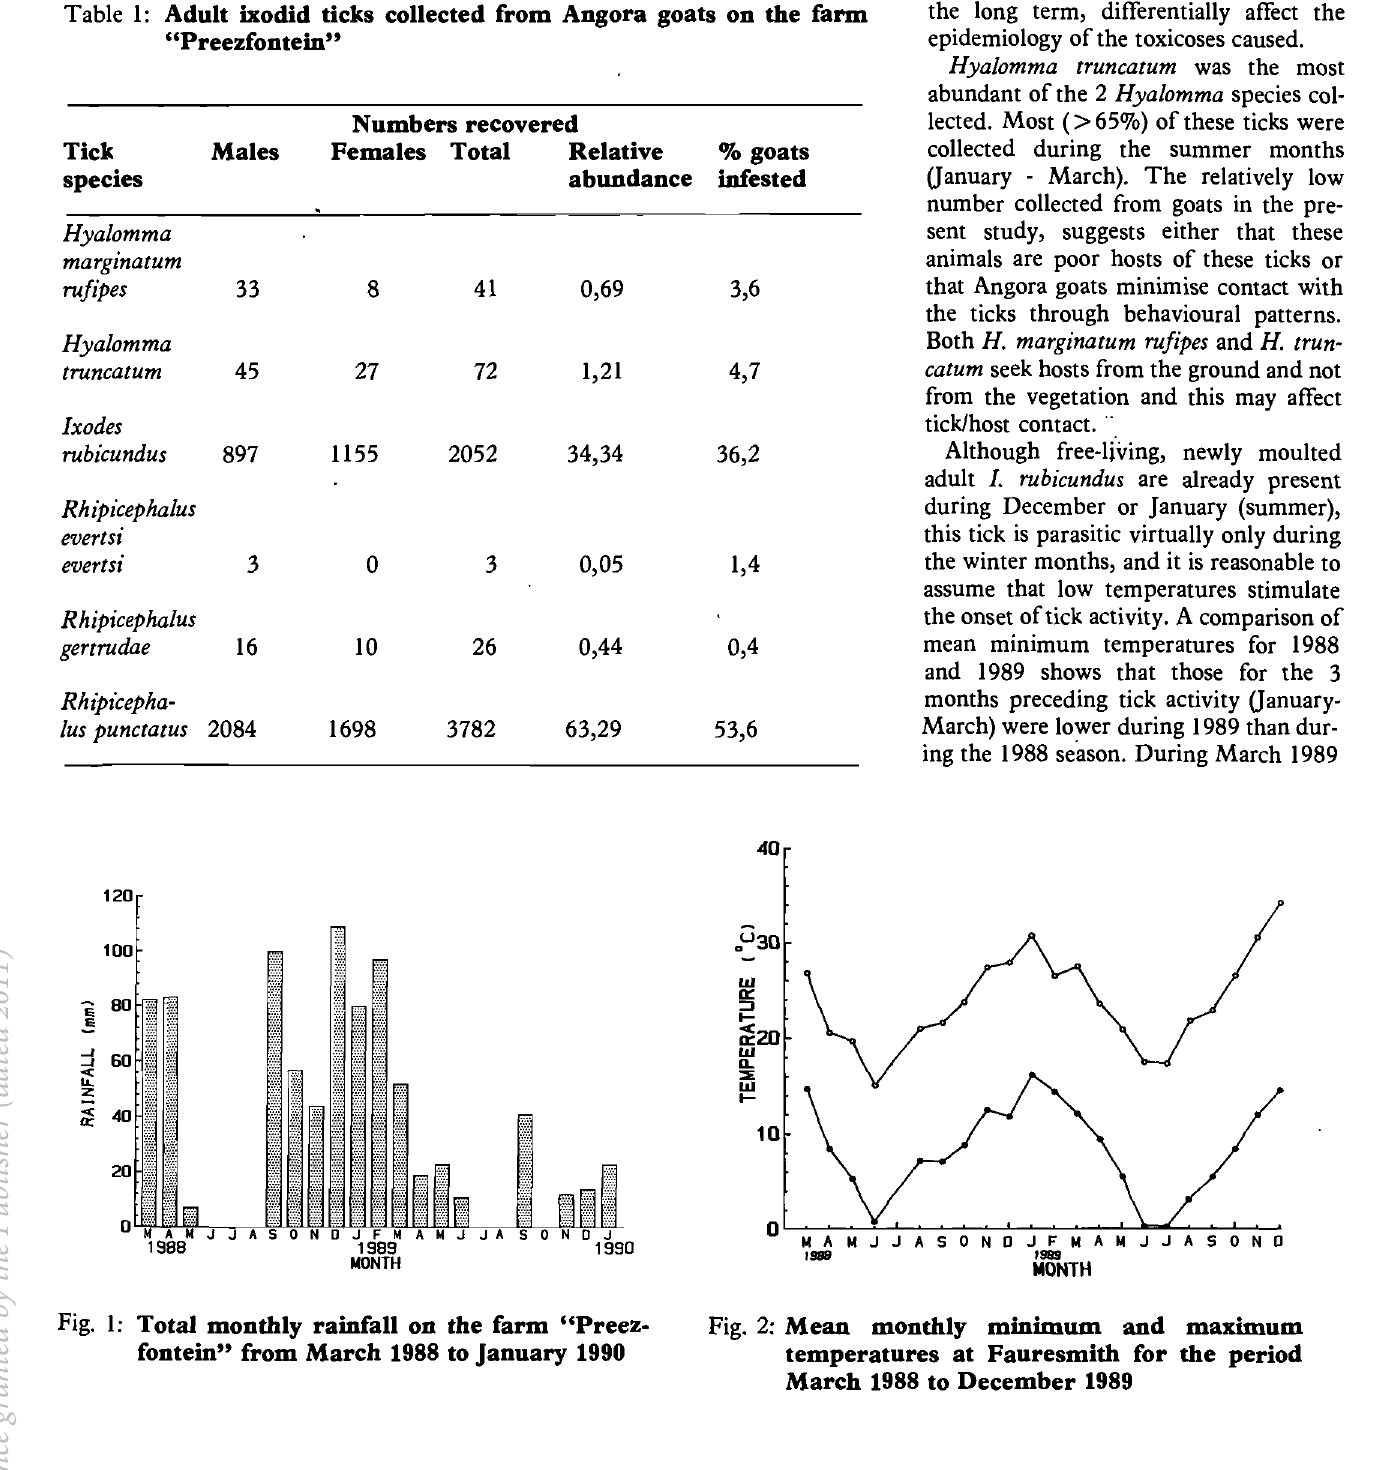
Fig. 1: Total monthly rainfall on the farm "Preez Fig. 2: Mean monthly minimum and maximum temperatures at Fauresmith for the